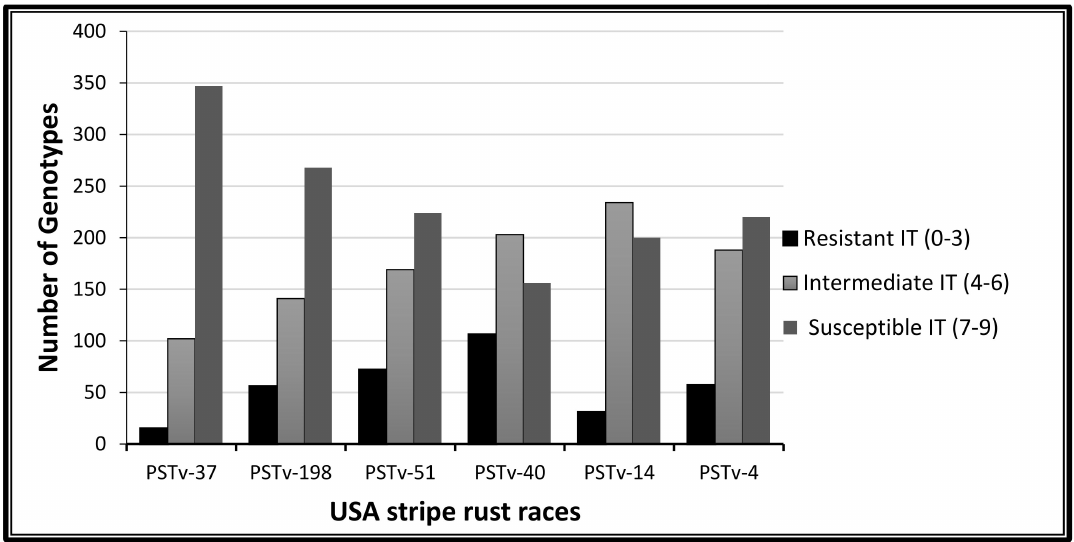
Figure 1. Infection distribution of the 465 spring wheat genotypes at the seedling stage based on their infection type (IT) score, tested with six stripe rust races from the USA.